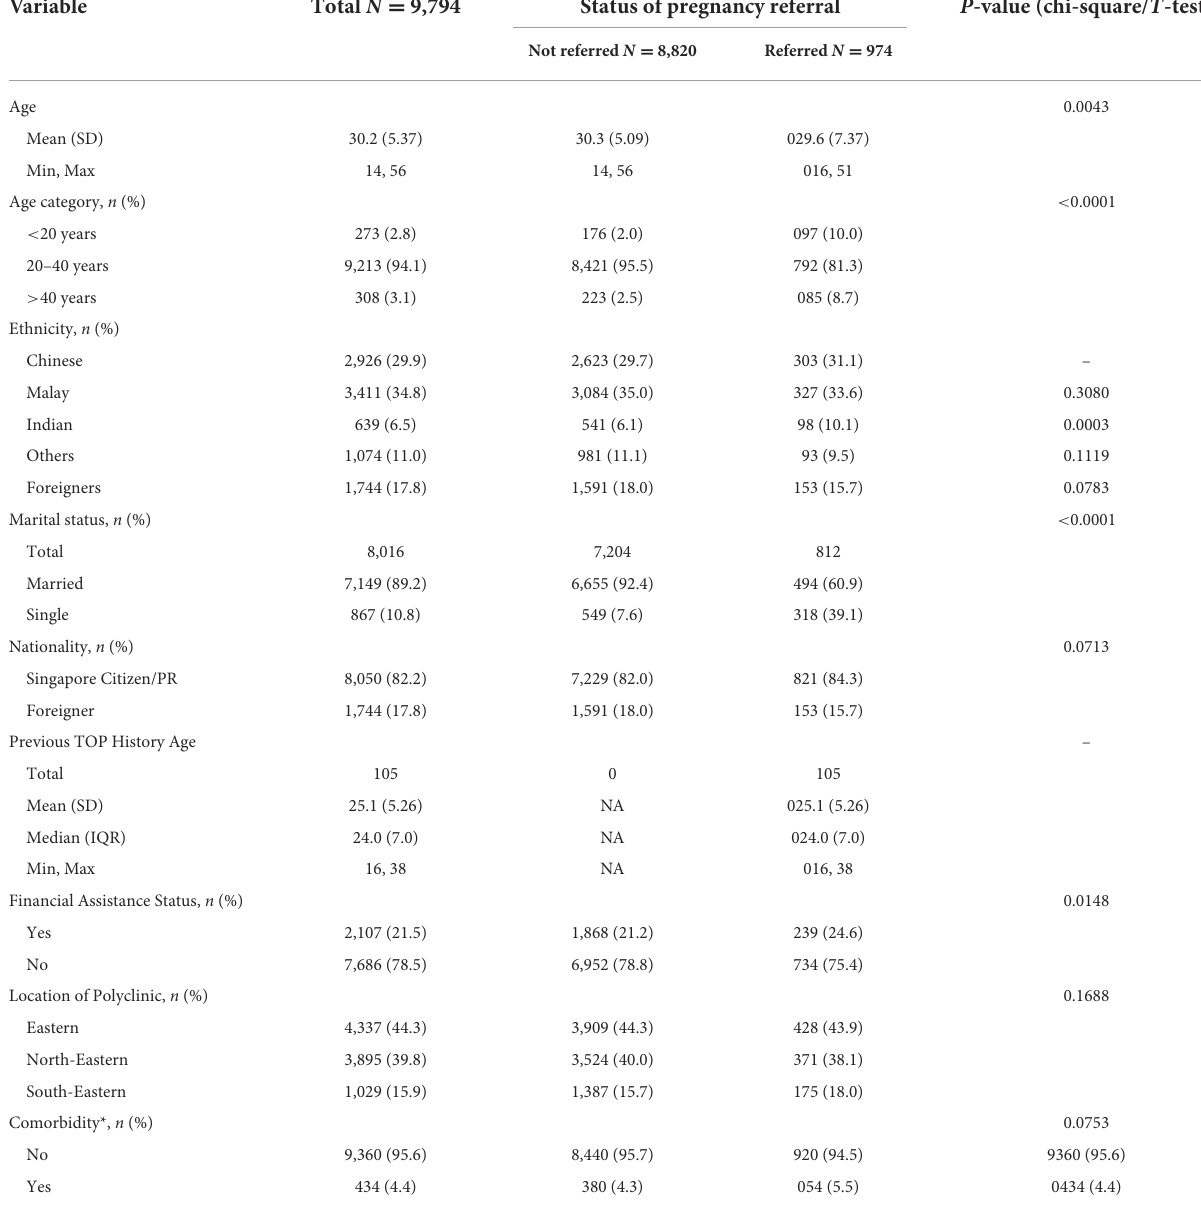
TABLE 1 Profile of women attending their antenatal visit and women requesting referrals for unintended pregnancy. Variable